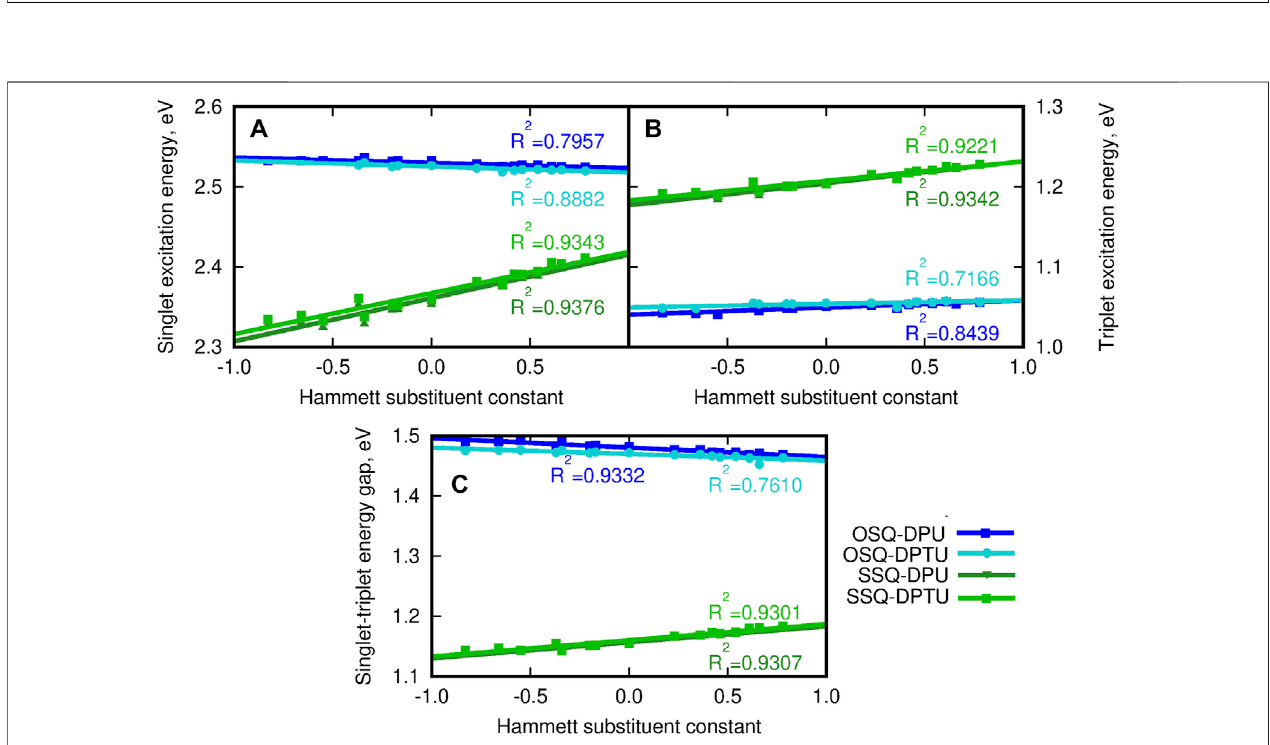
FIGURE 14 | (A) Vertical singlet excitation energy (eV), (B) vertical triplet excitation energy (eV), (C) singlet – triplet energy gap (eV) for the investigated complexes versus the Hammett substituent constant for substituents in N,N ′ -diphenyl(thio)urea estimated within the CAM-B3LYP/6-31+G(d) approach. The reference triplet excitation energies for isolated squaraines are equal 0.8054 eV and 1.0280 eV, respectively, for oxo- and thiosquaraine; for the reference singlet excitation energy see panel (C) of Figure 13 .